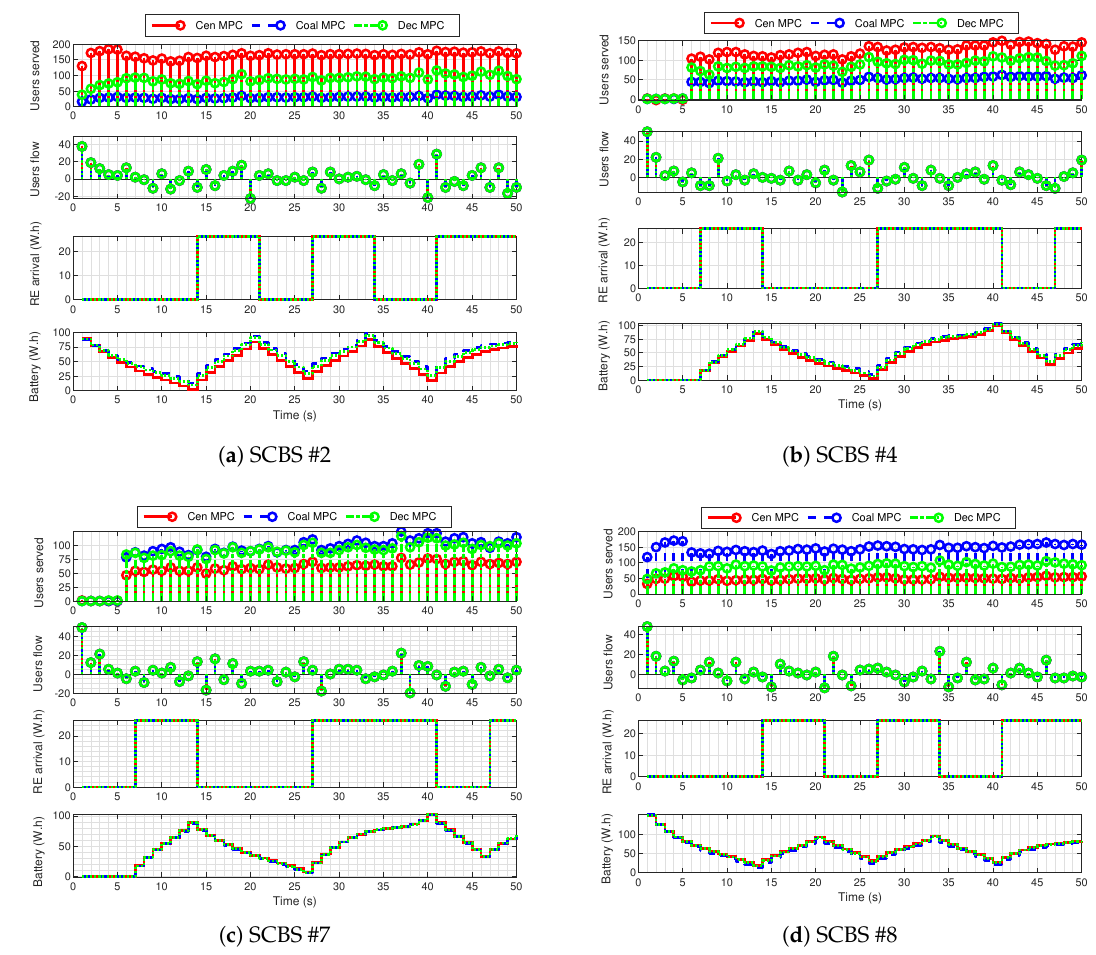
Figure 6. Comparison of four SCBSs from the 9-BS network. In each subfigure, the first row represents the user served by the SCBS; the second one is the user flow expected; the third row depicts the renewable energy arrival; and the fourth one shows the energy stored in the